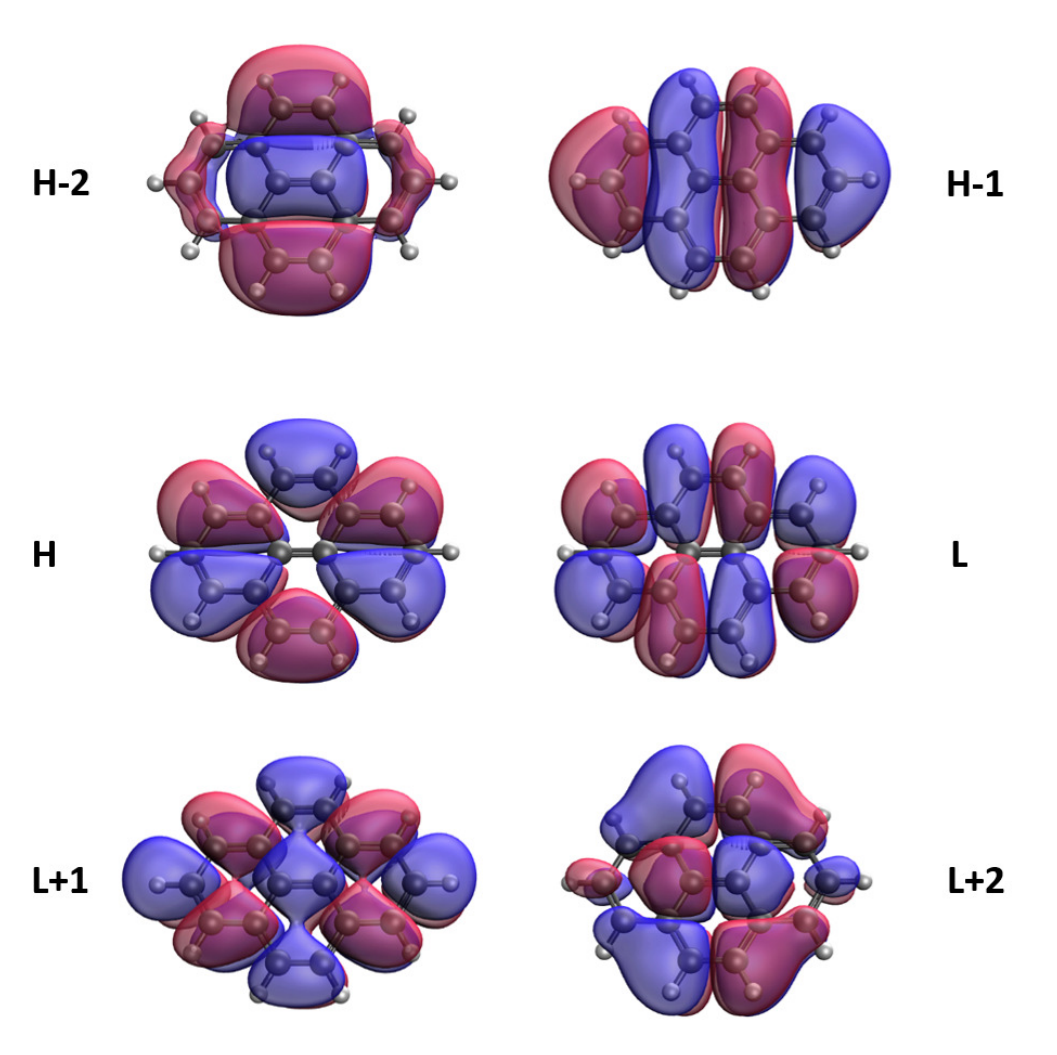
Figure 8. Real-space representation of H − 2 (2.000), H − 1 (2.000), H (1.998), L (0.002), L+1 (0.000), and L+2 (0.000) of ground-state 2-pyrene, calculated by spin-restricted TAO-LDA. Here the isovalue is 0.02 e/Å 3 . The occupation numbers of active orbitals are given in parentheses, and HOMO/LUMO is denoted as H/L for